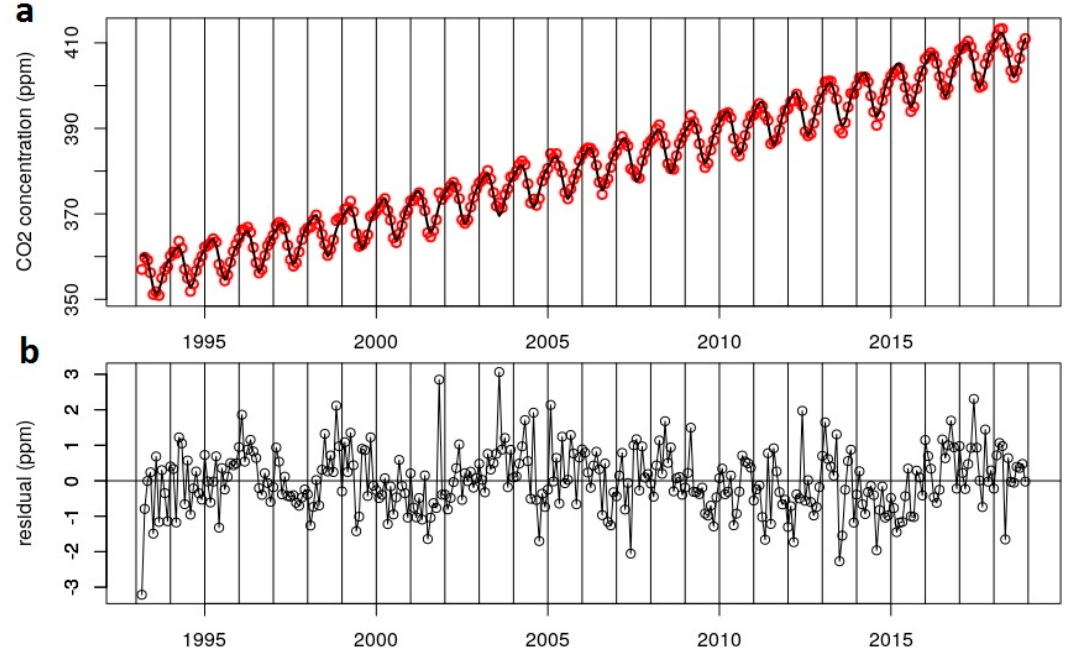
Figure 10. Mean background monthly values at Plateau Rosa from 1993 to 2018 (red points), the exponential and periodic fitting functions (Equation (4)) (black line) ( a ), residuals between the data and fitted curve ( b ). Table 2. Values of significant coefficients in Equation (5).